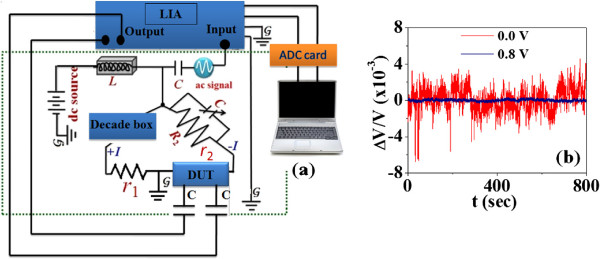
Noise detection scheme and time series of resistance fluctuations. (a) The schematic diagram of the ac noise detection scheme with the application of dc bias. (b) The typical time series of resistance fluctuations for two representative dc bias voltages but with the same Vac.